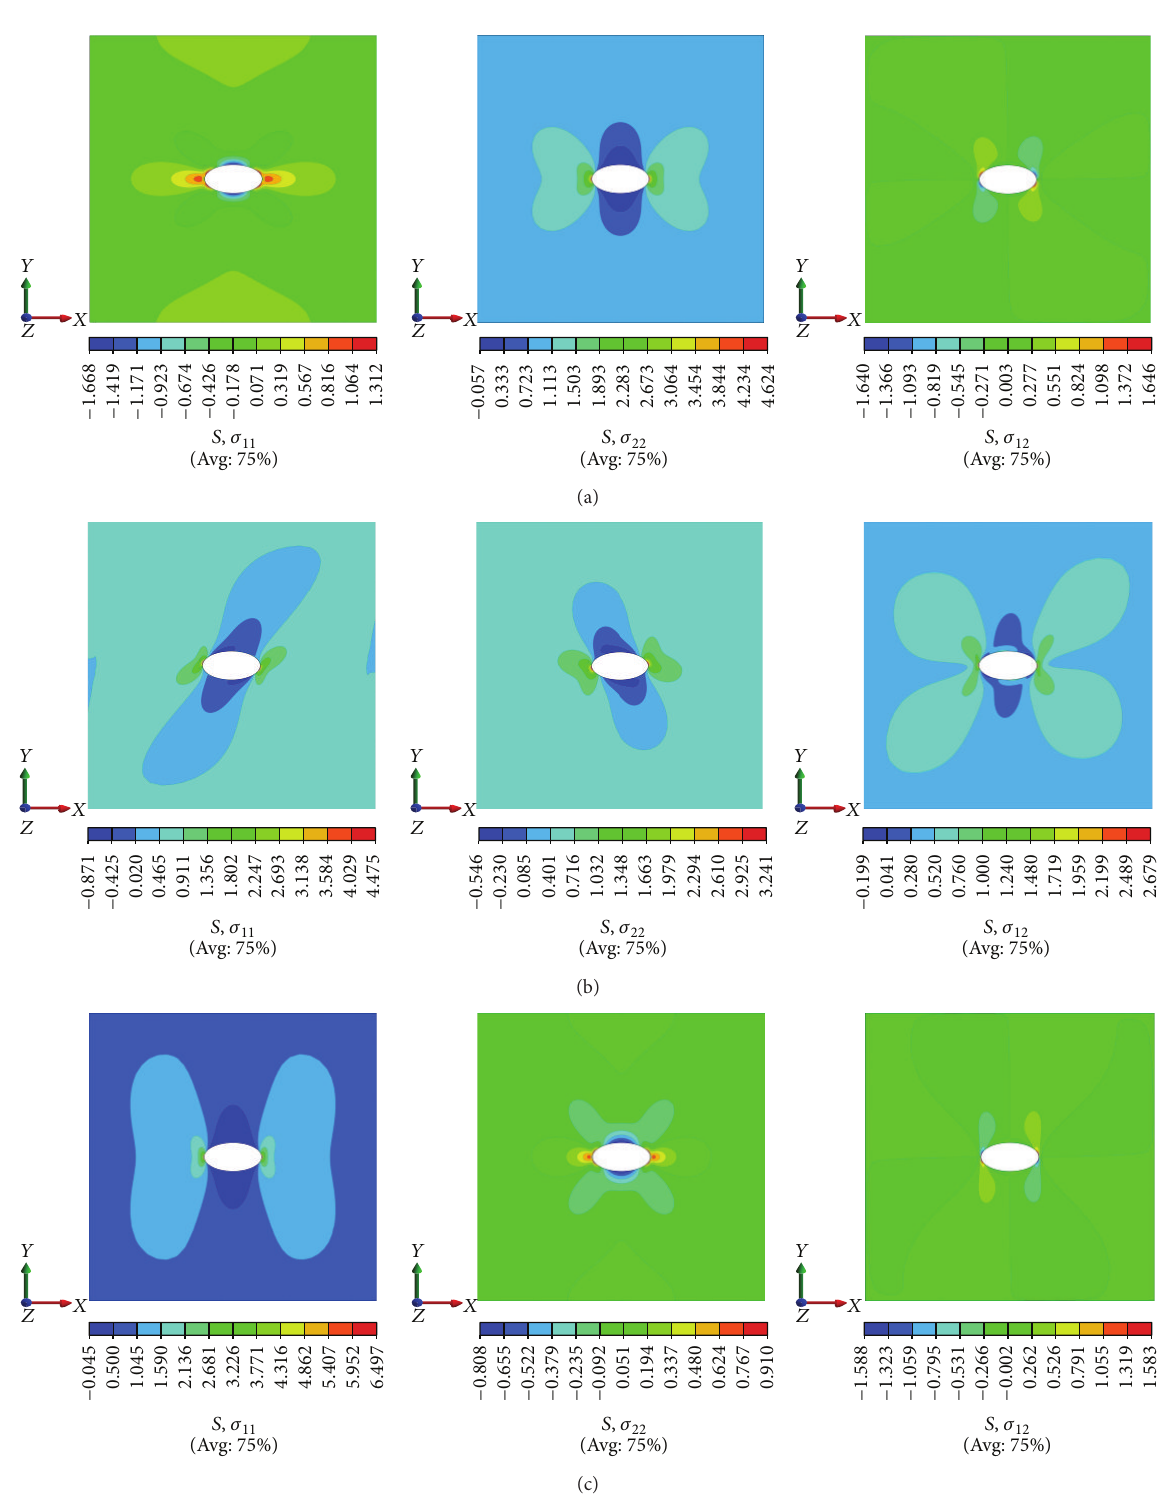
Figure 19: Contour plots of stress components around the elliptic hole in the composite plate: (a) 𝜑 = 0 ∘ , (b) 𝜑 = 45 ∘ , and (c) 𝜑 = 90 ∘